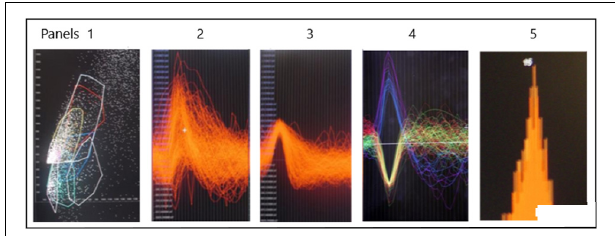
FIGURE 4 | Identification of possible SUs. Panel 1 shows a dot plot of, for example, amplitude versus width of spike. Densities of dots is selected by the user in panel 1 and the many spikes are displayed in panel 2. The putative single spike is separated from other putative spikes by cutting it away using the white marker shown above and below the area of interest. This putative spike is shown in panel 3. Examples of SUs are shown in panel 4. Autocorrelation in panel 5 suggests that the example is likely a SU. The different colors are to distinguish different single units.